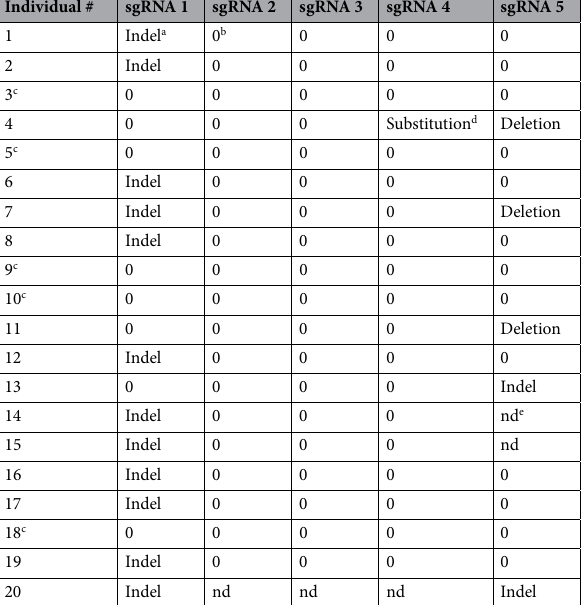
Table 1. Mutations corresponding to sgRNA target sites in PgABCA2 gDNA in 20 Cry2Ab-resistant pink bollworm larvae from the G 4 of the CRISPR-R2 strain. a Insertion/deletion mutation. b Wild-type, sequence identical to PgABCA2 from APHIS-S. c Lacked mutations at all five sgRNA target sites. d Single base pair substitution. e Not determined, unable to sequence the PCR